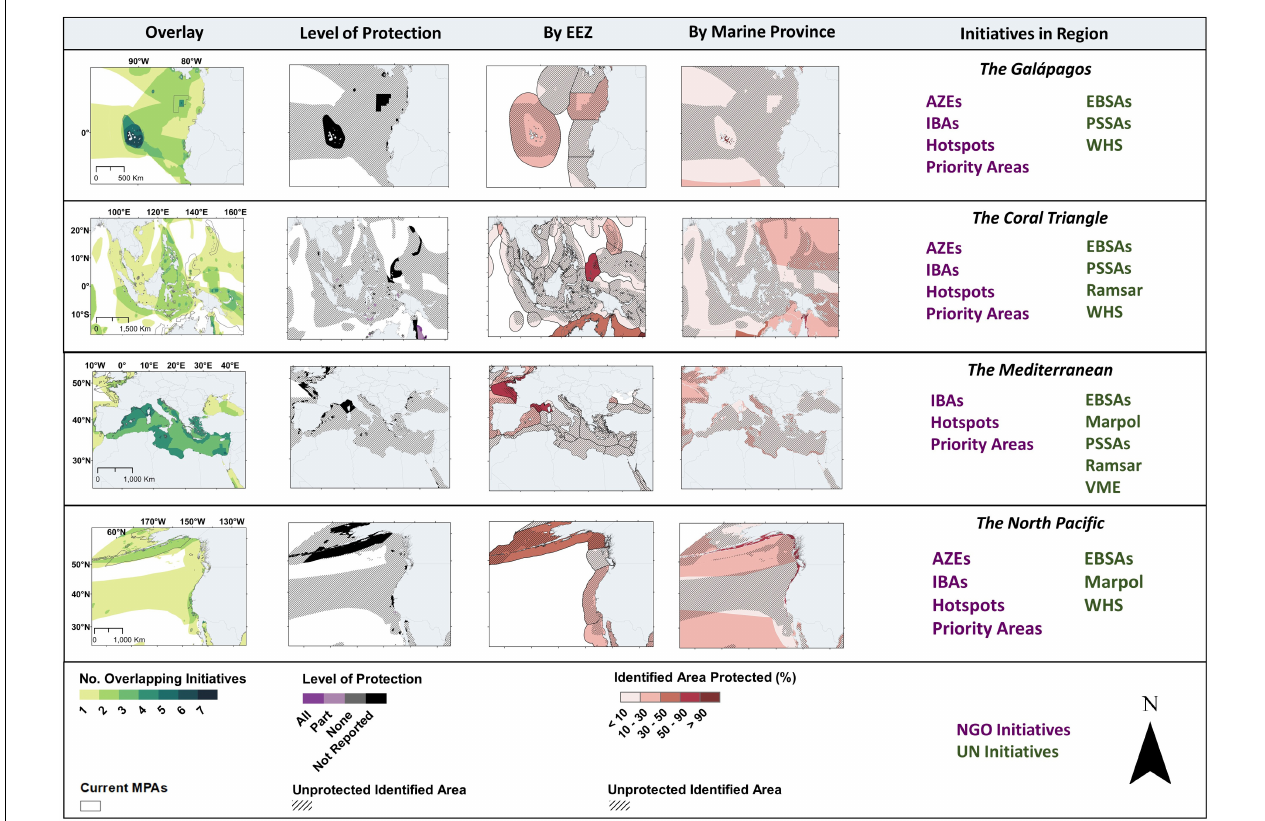
FIGURE 5 | Examples of important marine areas with opportunities for stronger, more representative, and/or more widespread protection. Areas were identified as important by six United Nations and four non-governmental organization initiatives that vary in purpose and scope. For each region, information is provided on the number of overlapping initiatives, on the strength of current protection, on identified areas within marine provinces (MEOWs, Marine Ecoregions of the World; Spalding et al., 2007; PPOWs, Pelagic Provinces of the World: Spalding et al., 2012), and on identified areas within exclusive economic zones (EEZs, Exclusive Economic Zones; Flanders Marine Institute, 2018). Countries are displayed using data provided by Natural Earth (Admin 0 Countries 4.1.0; Natural Earth, 2018a).